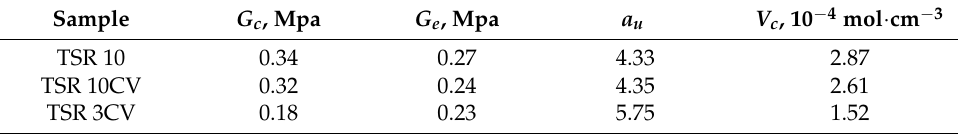
Table 4. Rubber network structure